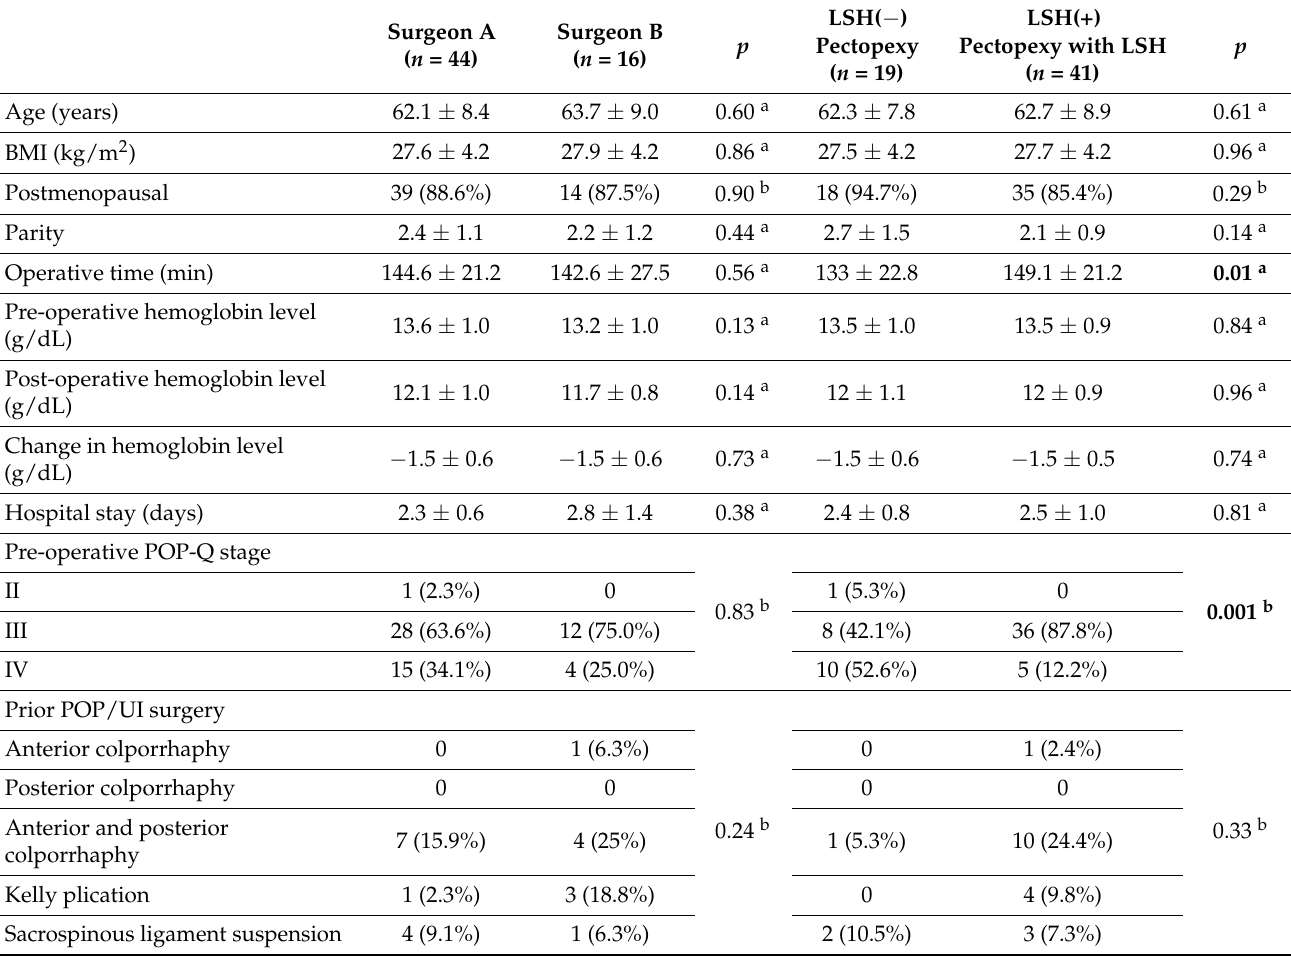
Table 1. Characteristics of the patients operated by surgeon A and B and dichotomized into LSH( − ) and LSH(+) groups. Surgeon A Surgeon ( n = 44)